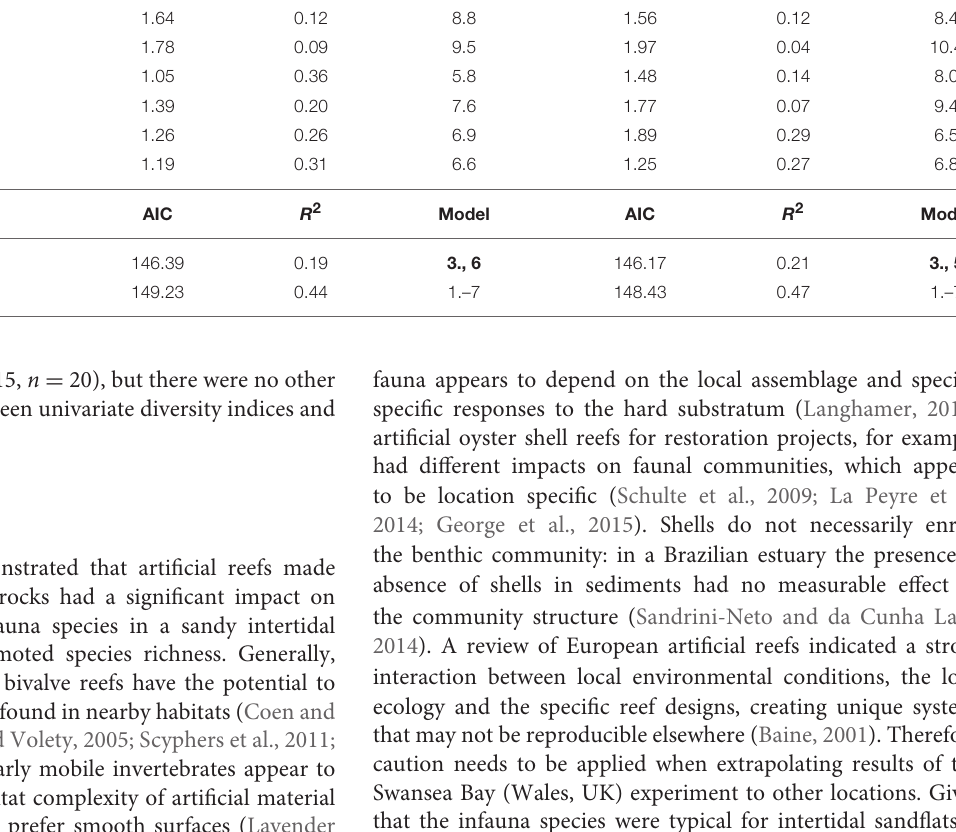
All benthos Benthos excluding C.